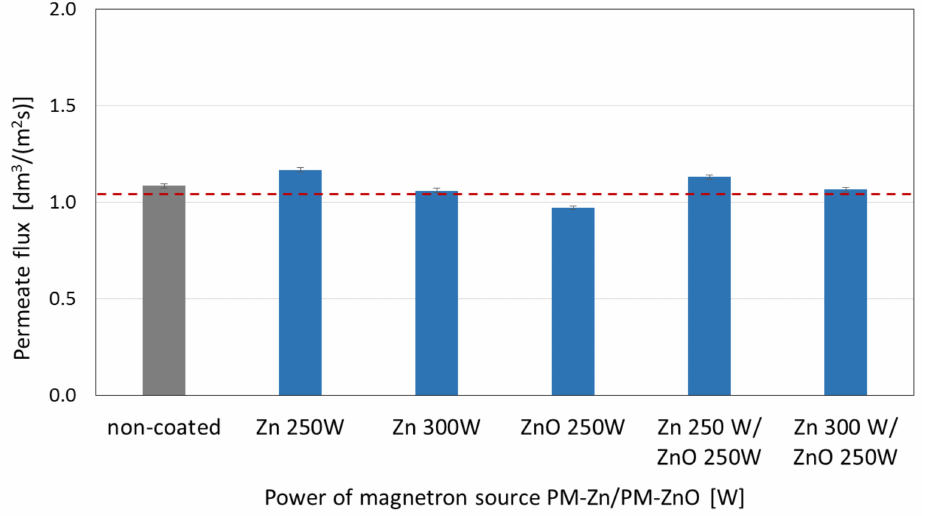
Figure 7. The effect of changing the magnetron power source for one-component Zn and ZnO coatings and two-component Zn/ZnO coatings covered the membranes’ surfaces on the permeate flux determined during